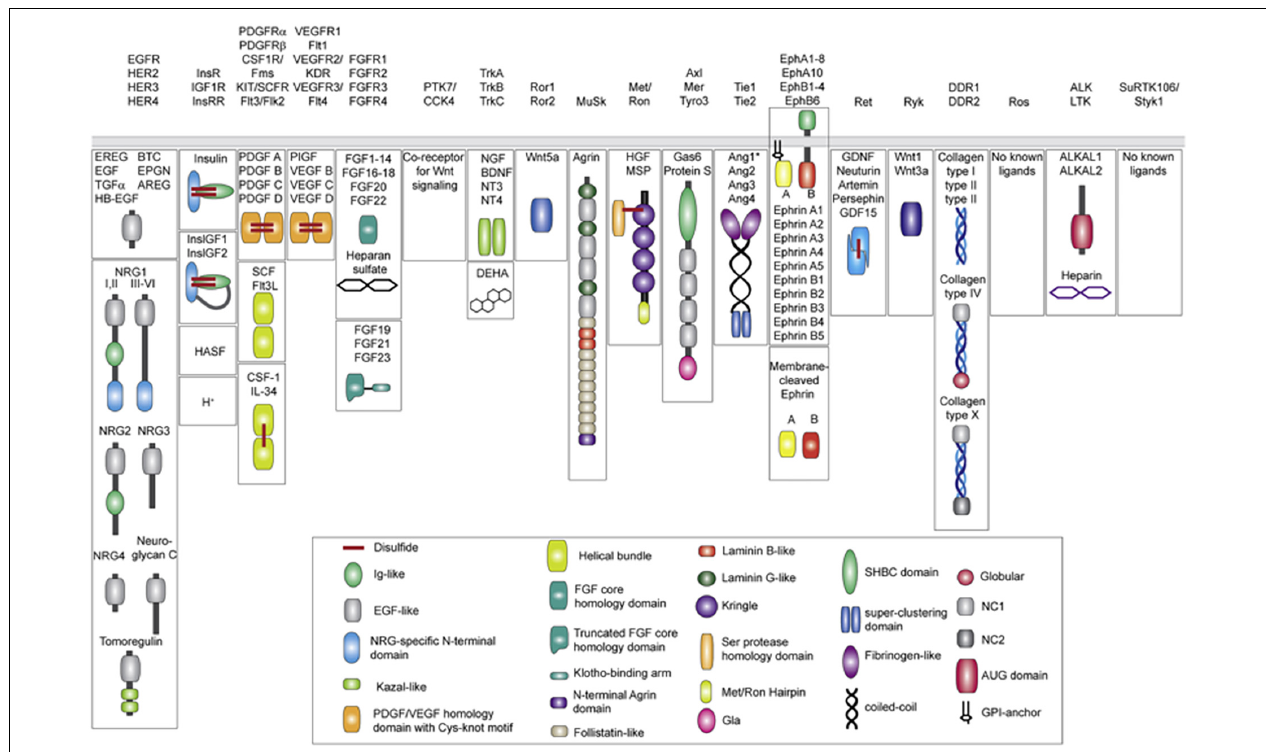
FIGURE 1 | Receptor tyrosine kinase ligands (Human). A total of 19 distinct RTK families (including recent revision removing the now Ser/Thr receptor kinases classified LMR1–3 family). Ligands for each RTK family are shown underneath in mature, secreted form. All membrane-tethered ligands are cleaved off the membrane except for ephrins, which activate their cognate receptors in a juxtacrine fashion. The ligands are drawn with their N-terminus pointing away from the membrane. Main structural domains are depicted in a cartoon form in their known oligomeric state except for Angiotensins, which may form higher-order oligomers in addition to dimers. If applicable, domain labels are included as captions. Sizes of individual domains are not drawn to scale. Reprinted from Lemmon and Schlessinger